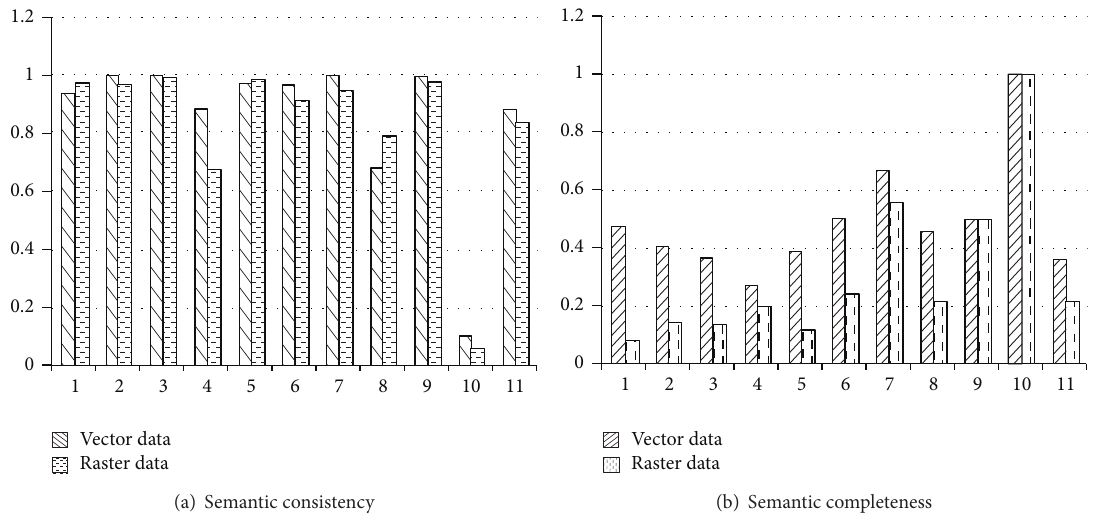
Figure 6: Histogram of semantic consistency and completeness of generalization of land use patch. Note: 1: cropland; 2: garden land; 3: forest land; 4: other agricultural land; 5: urban land; 6: rural residential land; 7: mining land; 8: traffic and water conservancy land; 9: other construction lands; 10: water; 11: natural reserve